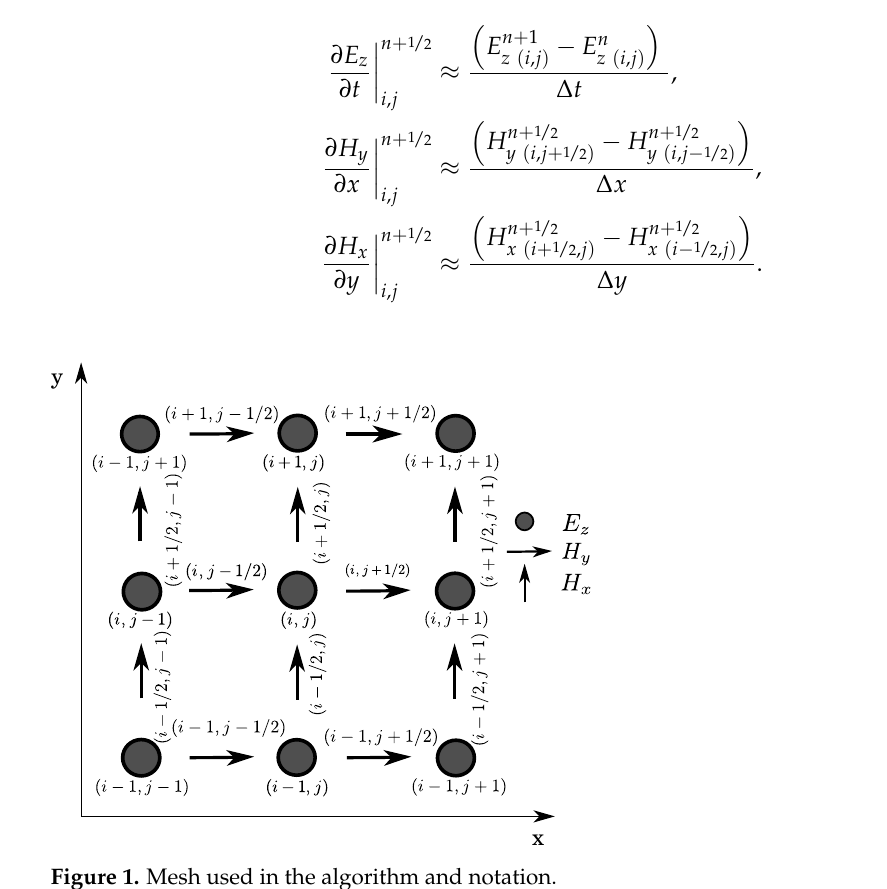
Figure 1. Mesh used in the algorithm and